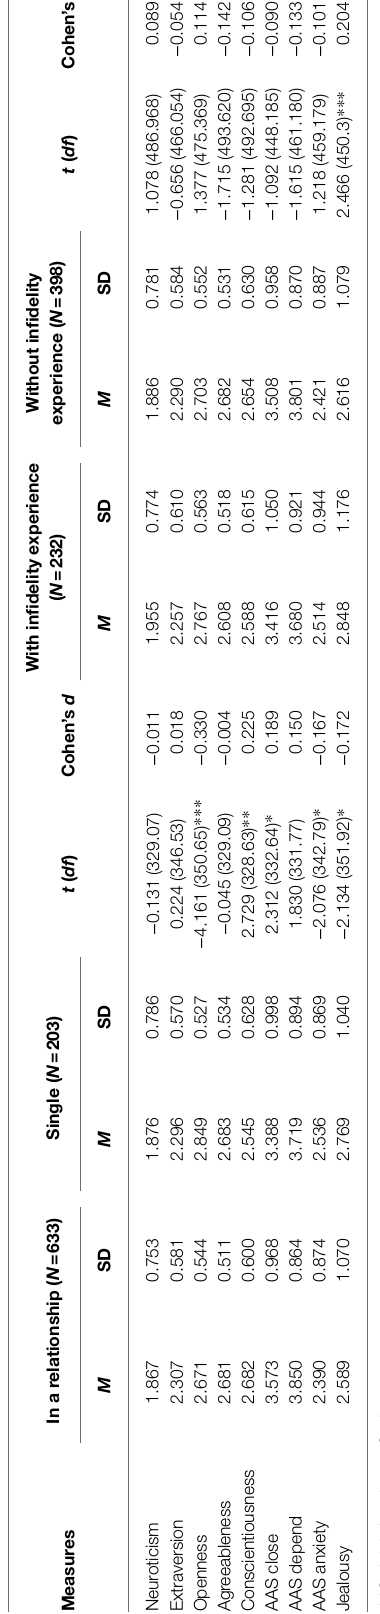
The path model with gender as grouping variable